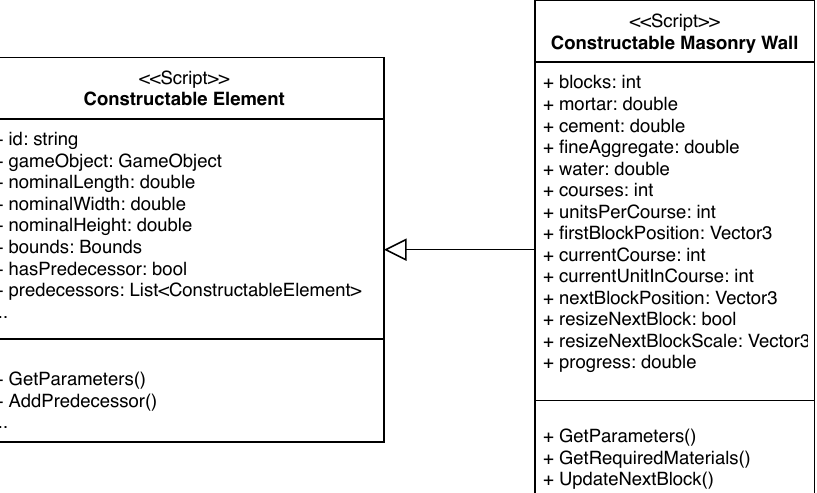
Figure 12. Constructable Masonry Wall class